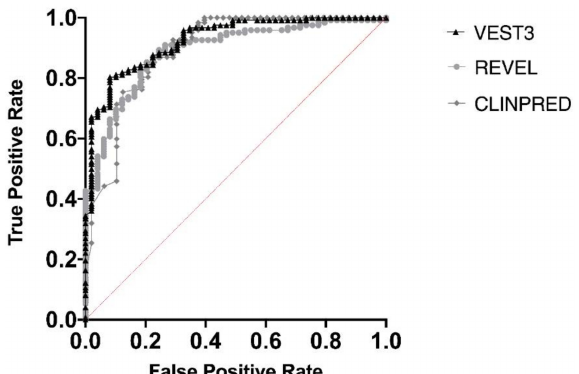
Figure 2. Overall performances of the three predictors on the NF1 missense variants. The area under the curve (AUC) is reported for each predictor.